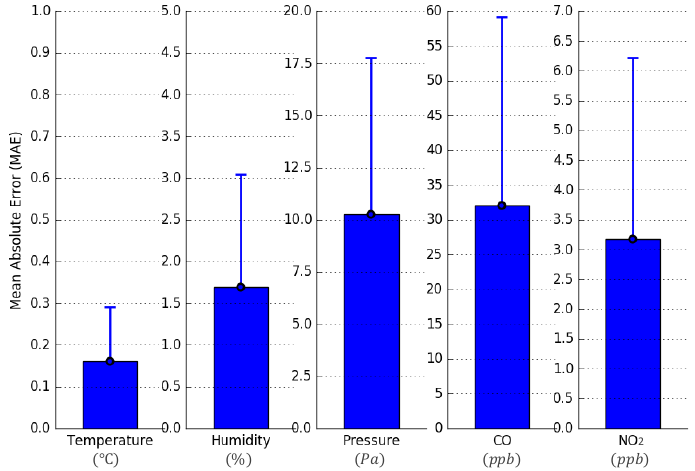
Figure 9. The Mean Absolute Error (MAE) and Standard Deviation (SD) values of the temperature, relative humidity, atmospheric pressure, CO, and NO 2